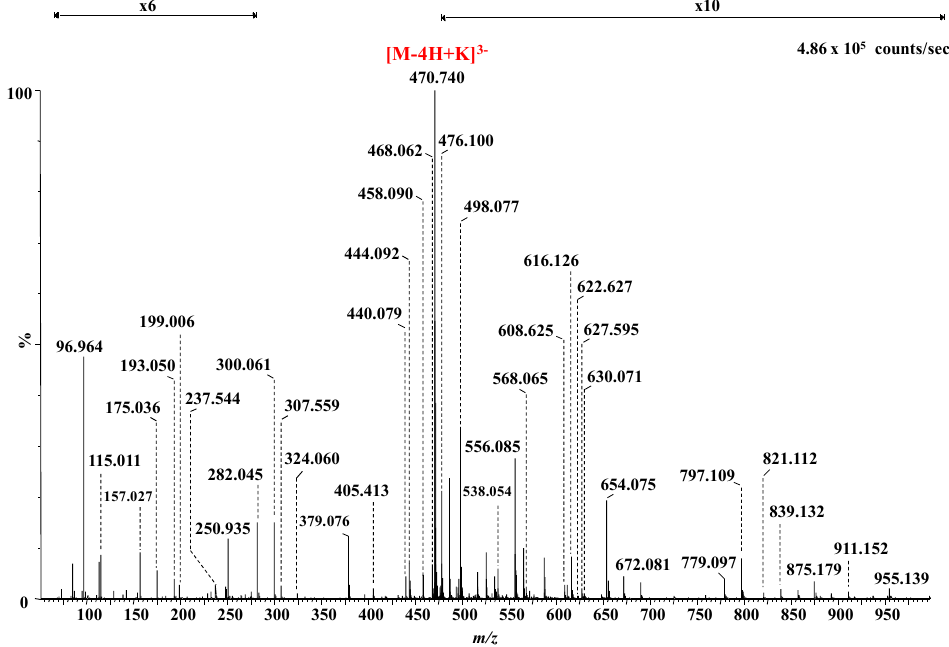
Figure 7. Negative ion mode nanoESI IMS CID MS/MS of the [M-4H+K] 3 − detected at m/z 470.714 in the MS depicted in Figure 4, corresponding to trisulfated 4,5- Δ -GlcAGalNAc[IdoAGalNAc] 2 . Collision energy 30 eV. For a better visualization of the fragment ions, the areas m/z 100 to m/z 350 and m/z 475 to m/z 1000 were magnified ×6 and ×10, respectively.